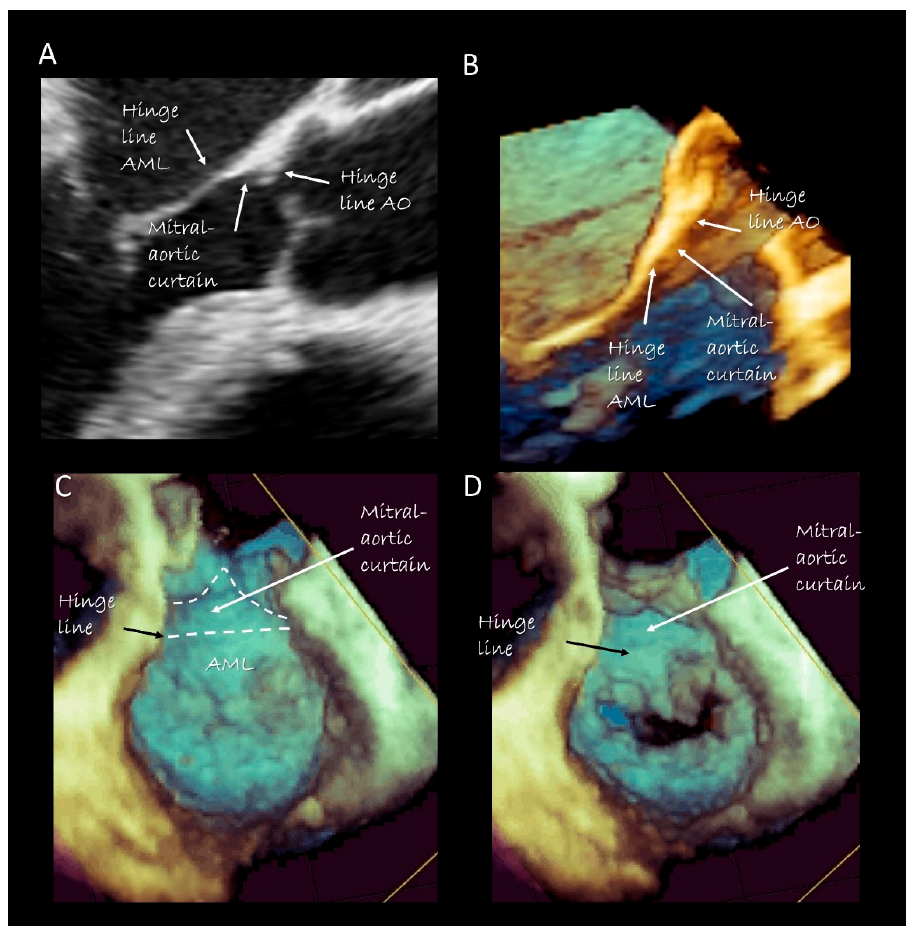
Figure 4. Two-dimensional ( A ) and three-dimensional ( B ) TEE cross-section long-axis view showing the hinge line of anterior mitral leaflet (AML), the hinge line of the aorta (AO) and in between the mitral aortic curtain. ( C , D ) 3D TEE from a ventricular perspective in systole ( C ) and in diastole ( D ), showing the mitral – aortic curtain in “en face” view.